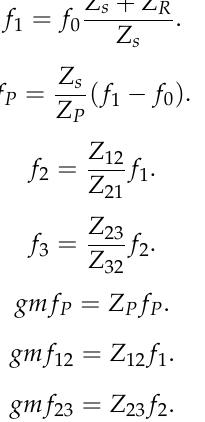
Table 3. Rotation and gear mesh frequencies as functions of the rotor frequency, f 0 .